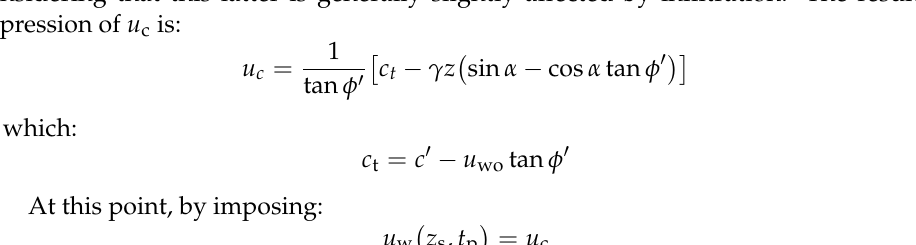
In Equation (15), c ’ and ' ϕ are the effective cohesion and the angle of shearing re-